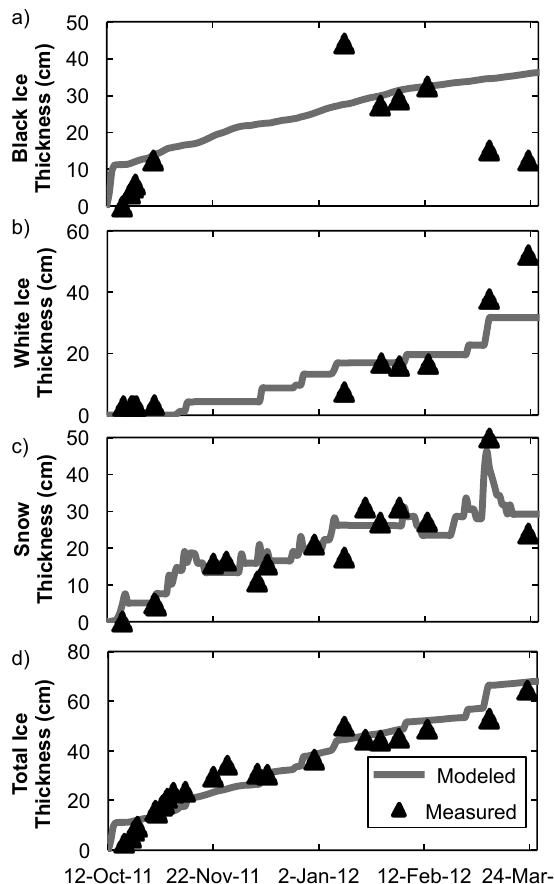
Figure 5. Modeled and measured thicknesses of (a) black ice, (b) white ice, (c) lake surface snow, and (d) the ice layer (white and black ice) during the winter of 2011–2012. A value of α = 0 . 95 was used in the ice growth model (Sect. 2.3.2) for this period.